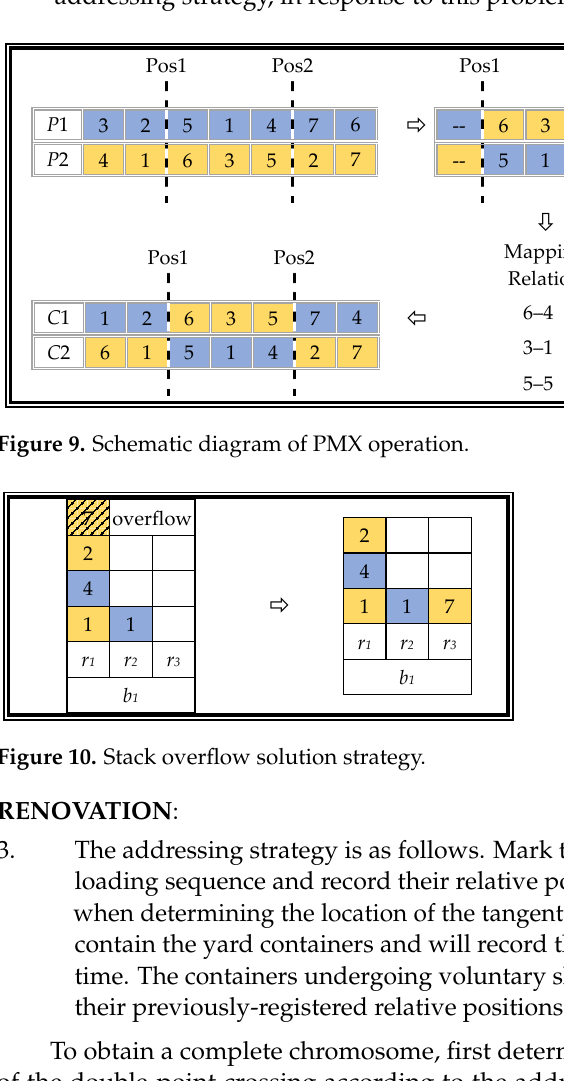
Figure 8. Illegal code generated by sequence code crossing.